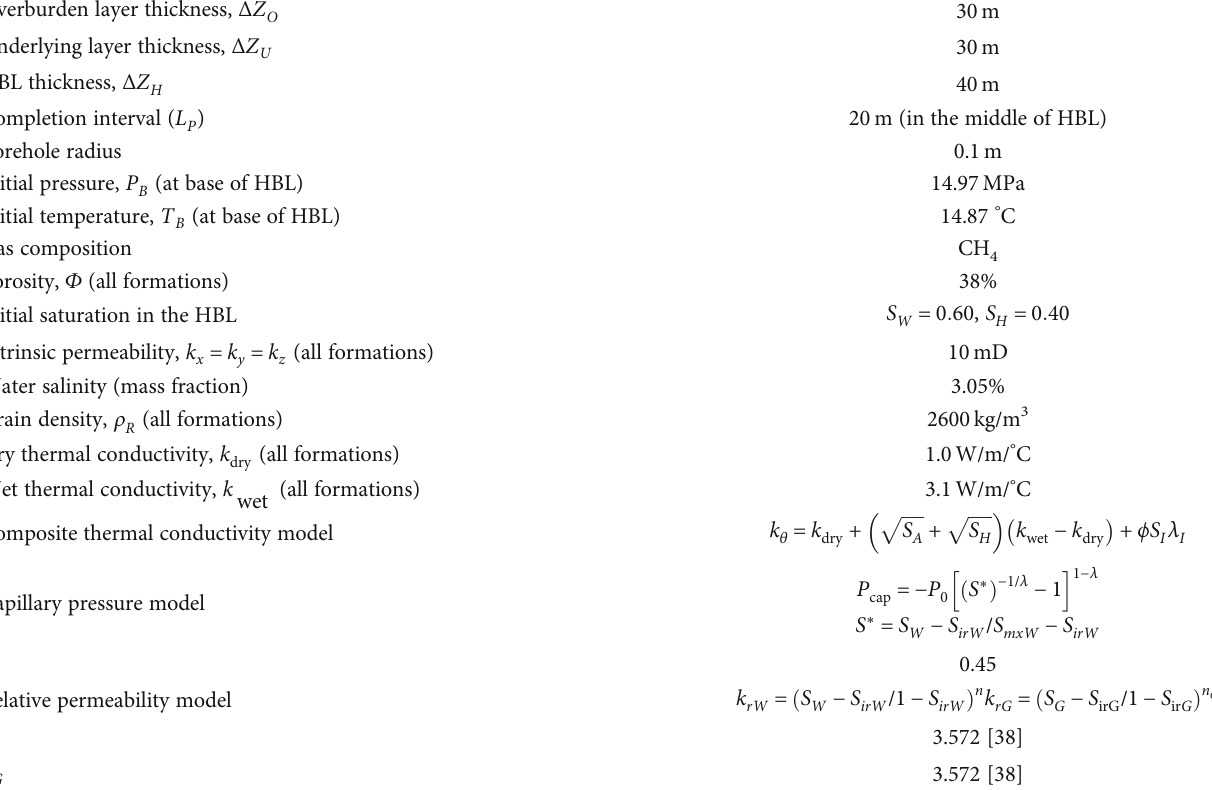
Table 1: Main hydrate reservoir properties and conditions in site SH2.